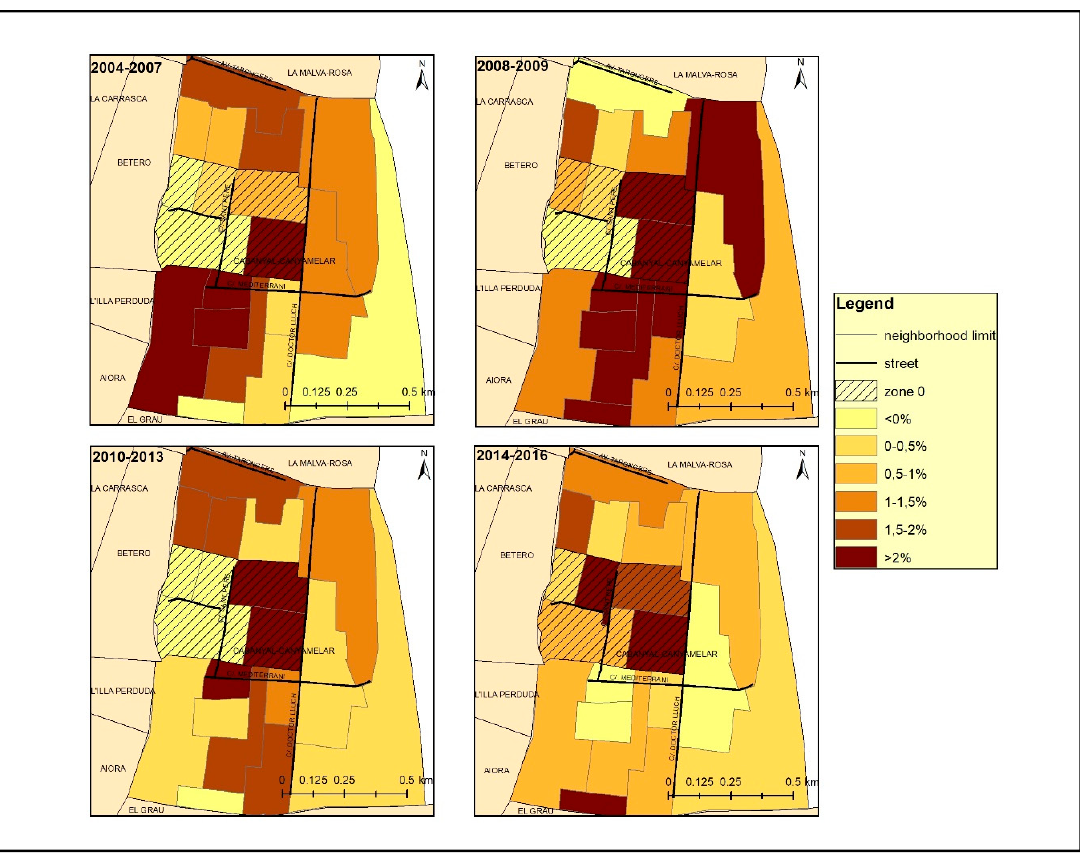
Figure 8. Migration balance in Cabanyal and zone 0, 2004–2016 [35].